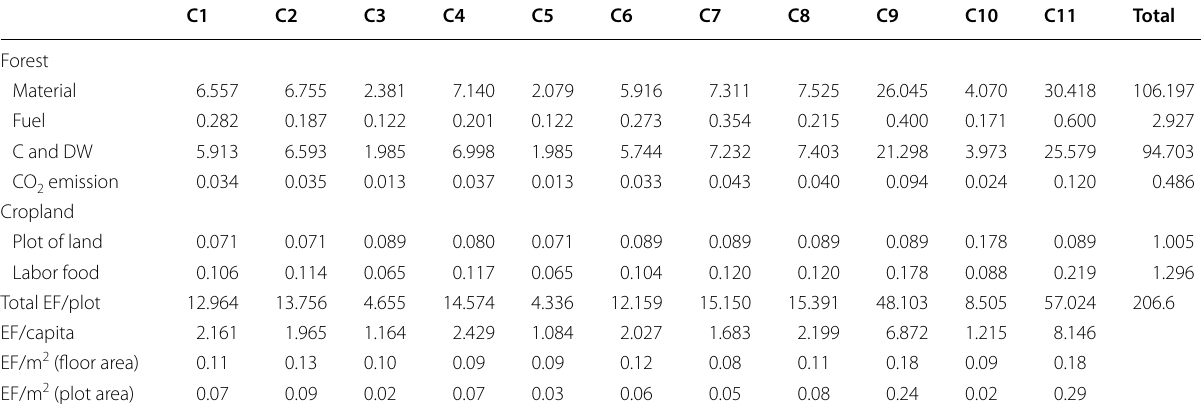
Overall computed ecological footprint: EF/capita